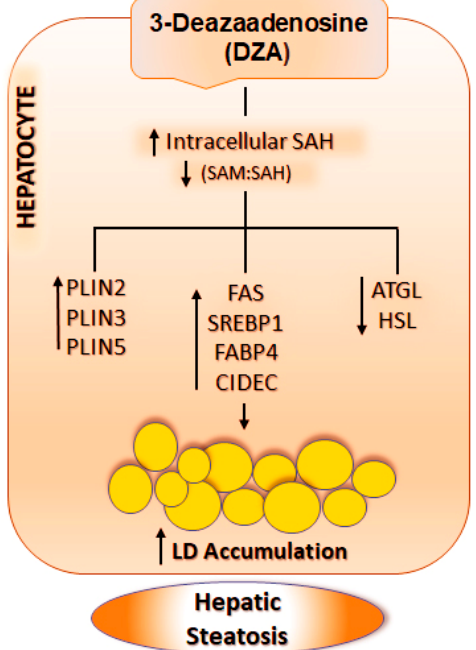
Figure 8. Schematic representation of the mechanism by which DZA results in LD accumulation in hepatocytes. DZA treatment causes a rise in intracellular SAH levels and reduces the SAM:SAH ratio in hepatocytes, which in turn, increases PLINs, enhances lipogenesis and decreases lipolysis. Collectively, these events promote increased LD accumulation in hepatocytes, characteristic of hepatic steatosis. The abbreviations used are as follows: SAH, S-adenosyl homocysteine; SAM, S-adenosylmethionine; PLINs, Perilipin; FAS, Fatty acid synthase; SREBP1, Sterol regulatory element-binding protein 1; FABP4, Fatty Acid-Binding Protein 4; CIDEC, Cell death inducing DFFA like effector c; ATGL, Adipose triglyceride lipase; HSL, Hormone-sensitive lipase.